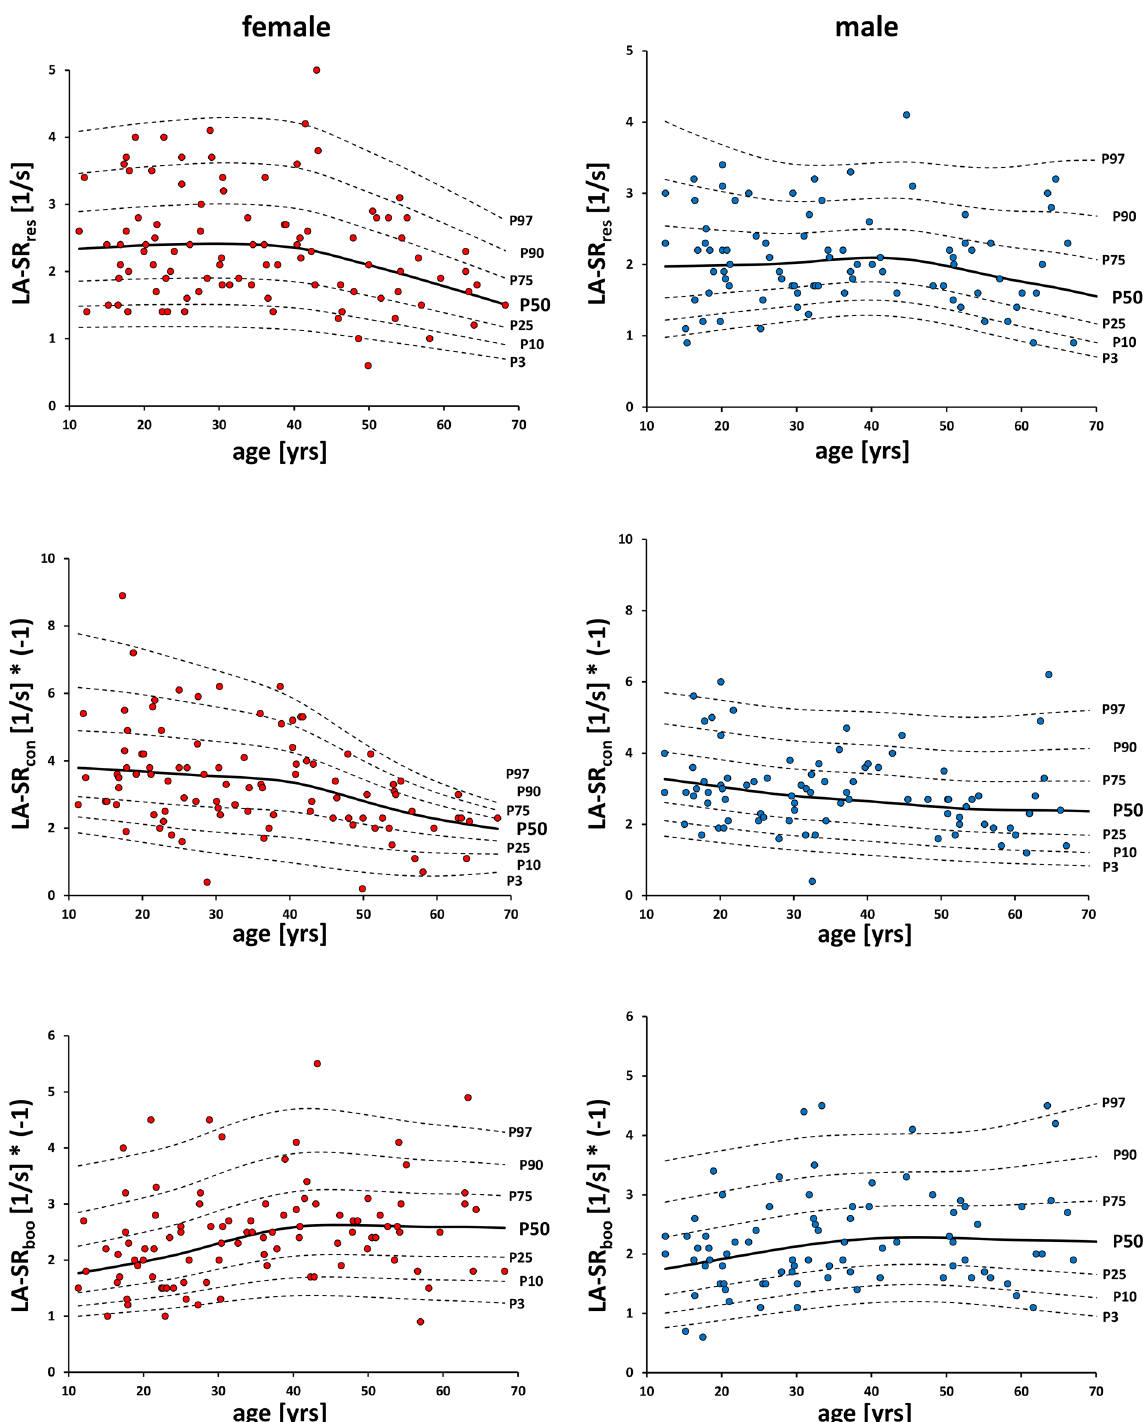
Figure 2. Gender-specific percentile curves of global longitudinal left atrial strain rate values by CMR feature tracking for reservoir, conduit and booster cardiac phase, respectively. LA-SR res reservoir left atrial strain rate, LA-SR con conduit left atrial strain rate, LA-SR boo booster left atrial strain